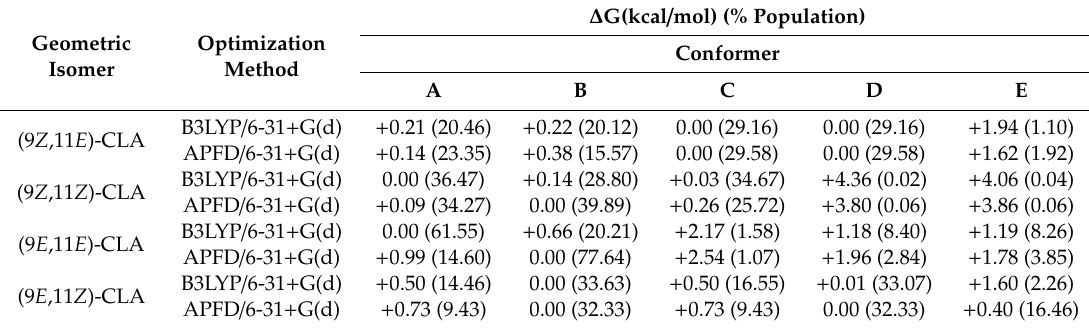
∆ G(kcal / mol) (% Population)